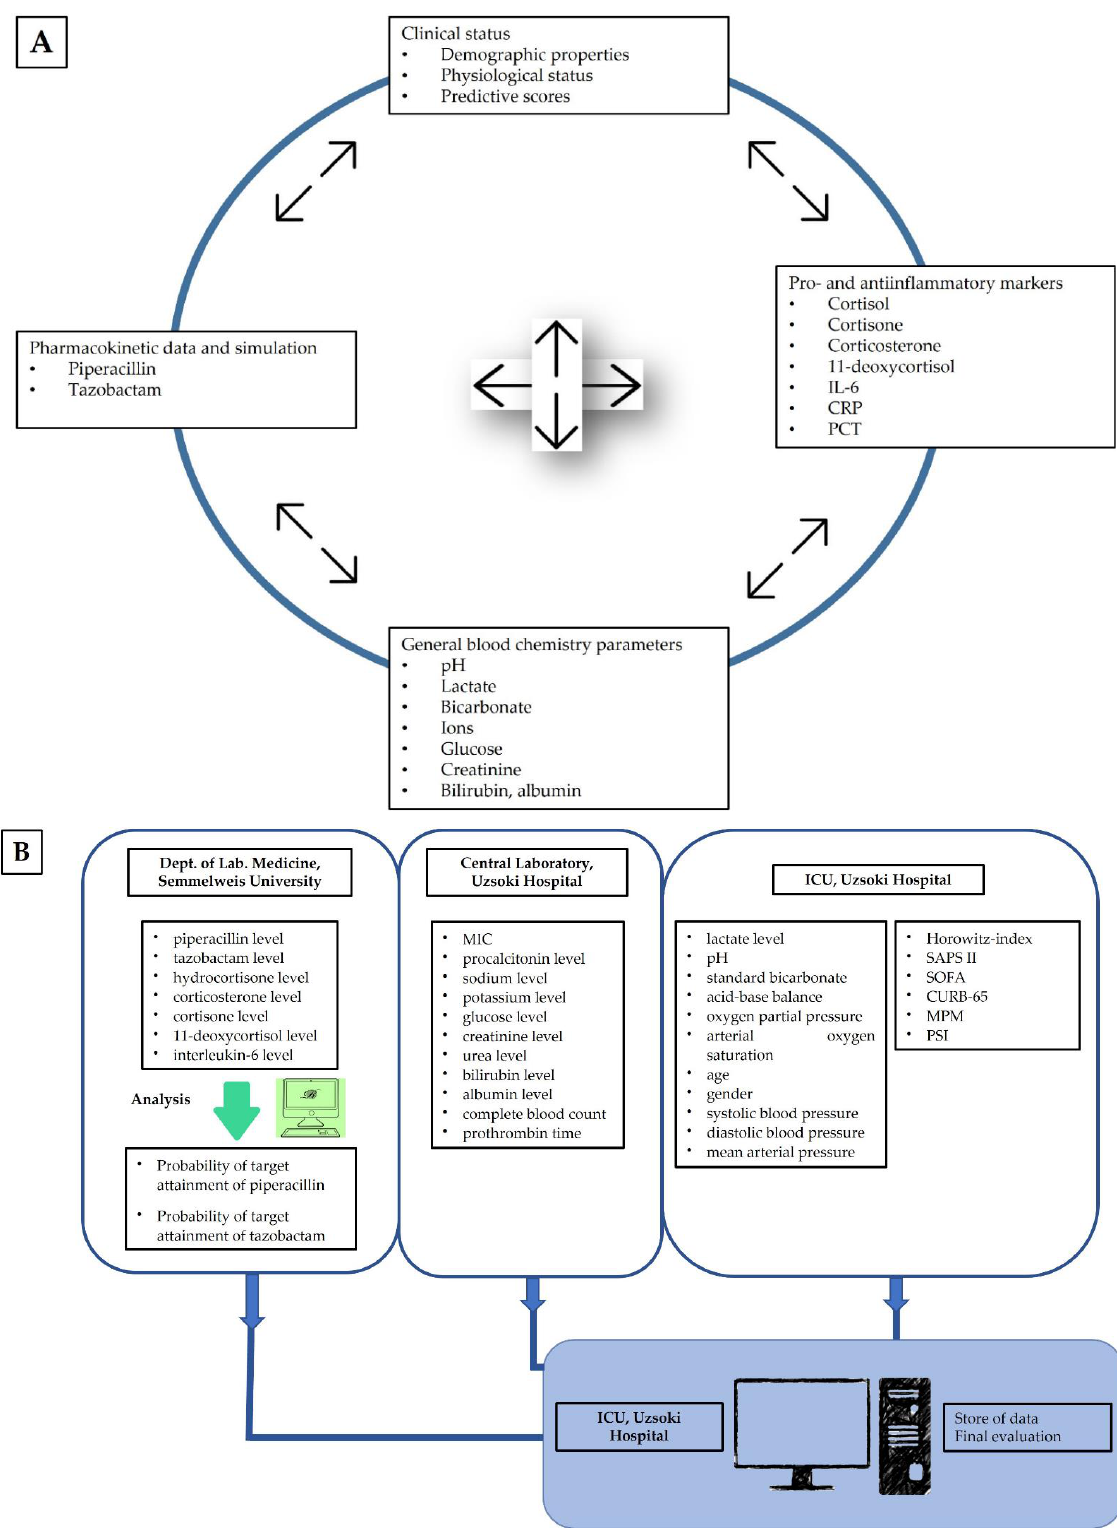
Figure 3. Measured parameters categorized by ( A ) study rationale and ( B ) the location of data collection, evaluation and storage. SAPS II simplified acute physiology score II; SOFA, sequential organ failure assessment; CRUB-65, confusion, uremia, respiratory rate, blood pressure, age > 65 years; MPM, mortality prediction model; PSI, patient safety indicators.